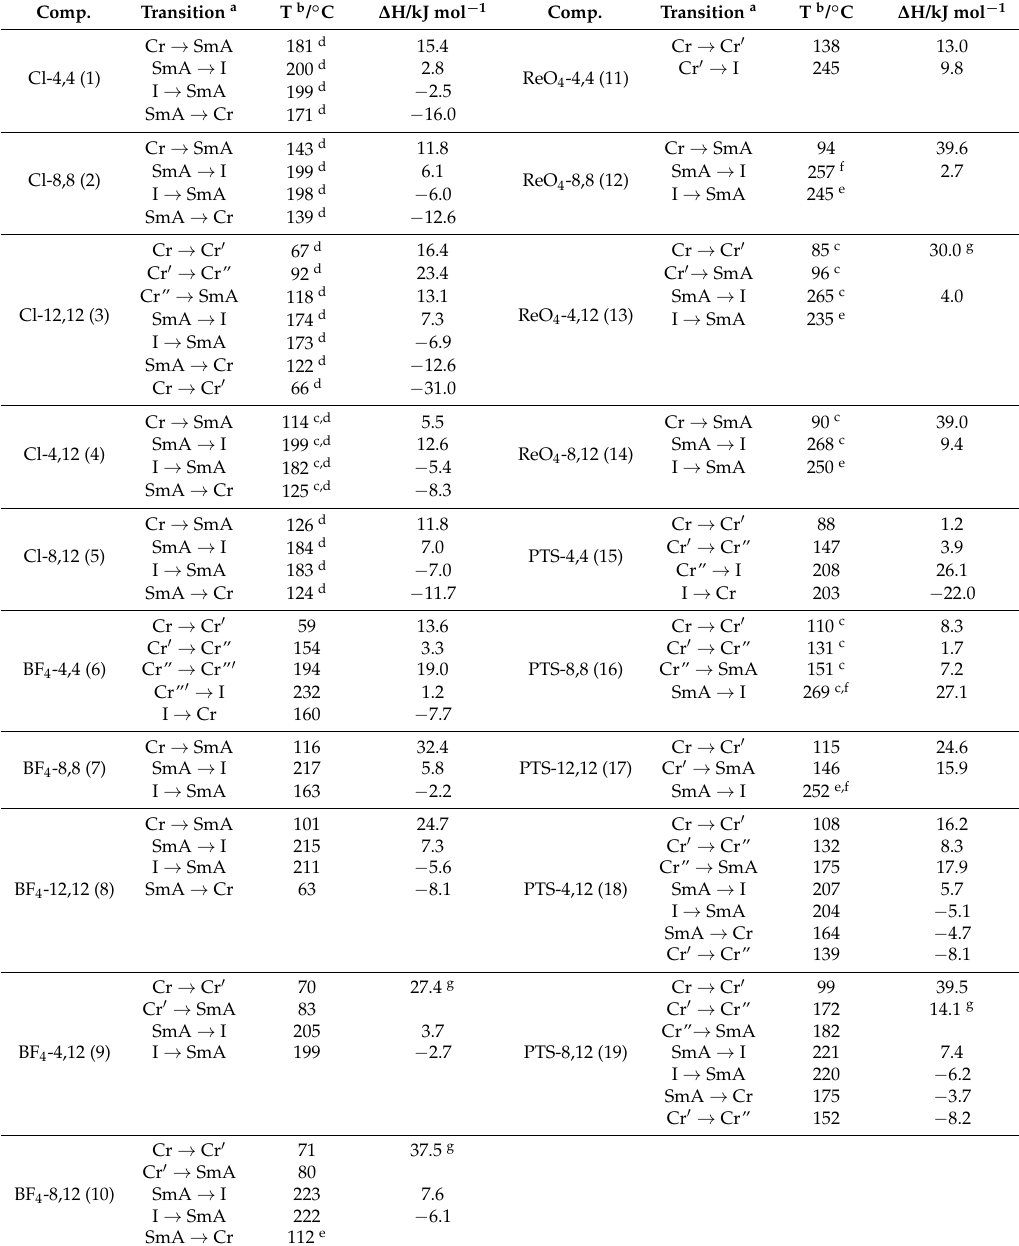
Table 2. Phase transitions of the compounds of the families I-IV determined by DSC and POM.